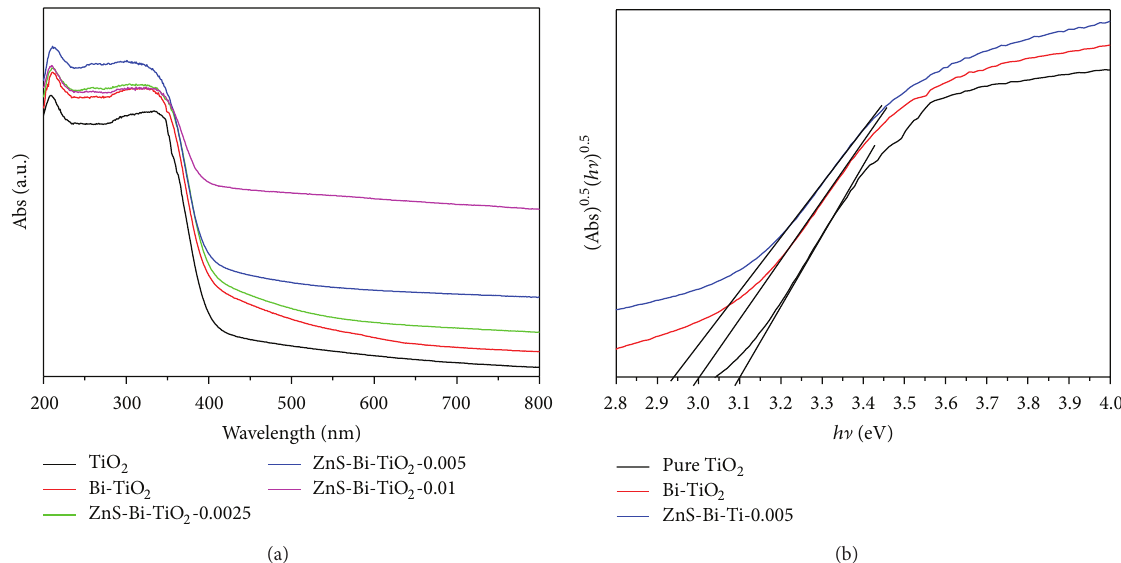
Figure 4: (a) UV-Vis spectra of the TiO 2 , Bi-TiO 2 , and ZnS-Bi-Ti- 𝑥 and (b) the calculation of energy band gap of the TiO 2 , Bi-TiO 2 , and